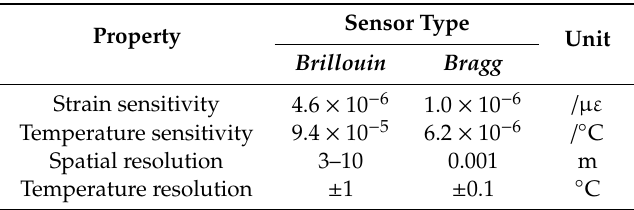
Table 1. Main Technical Specifications of Fiber Bragg Gratings (FBGs) and Comparison with Brillouin-based Sensors [11].